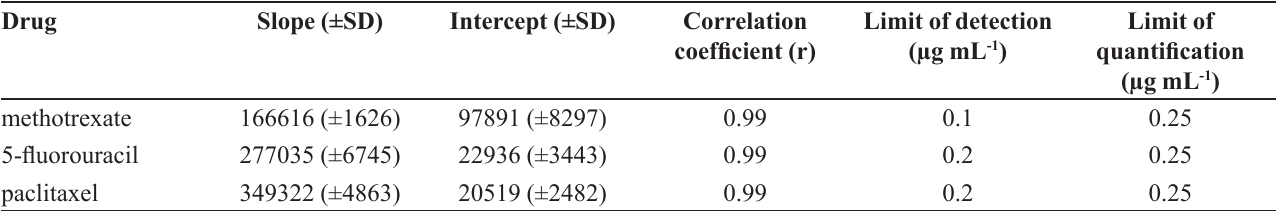
TABLE III - Slope (mAU/ m g mL -1 ) and intercept (mAU), with standard deviation (SD) and correlation coefficient in the range 0.25 to 20 m g mL -1 , and limits of detection and quantification for the proposed method Drug Slope (±SD)